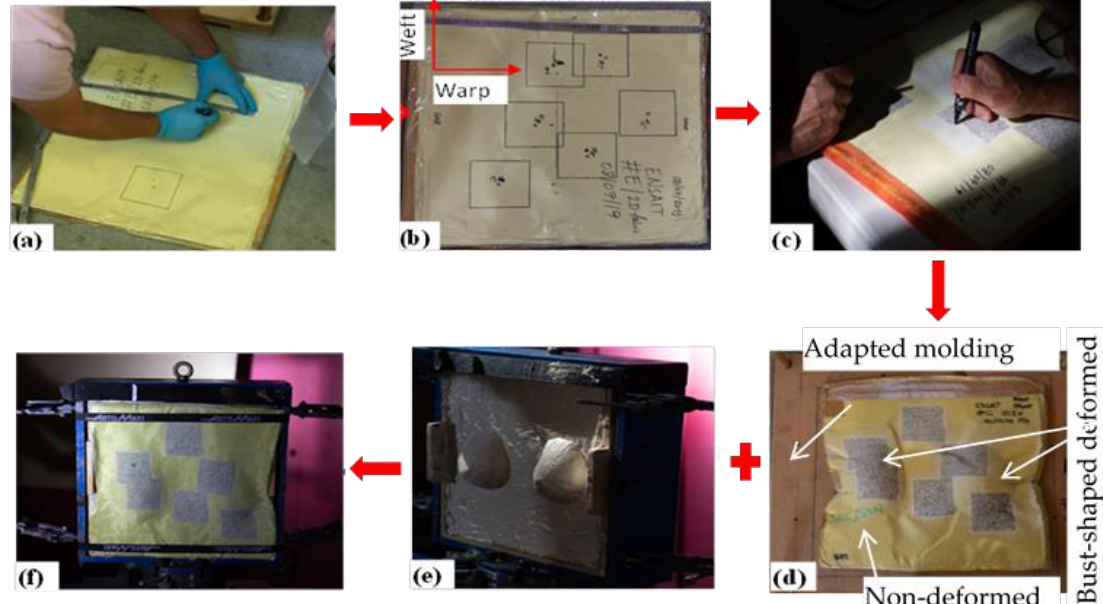
Figure 4. Sample preparations process. ( a ) Preparing projectile shot locations; ( b ) shot target regions identifications; ( c ) speckle patterns drawing on the shot region; ( d ) molding of target panel on